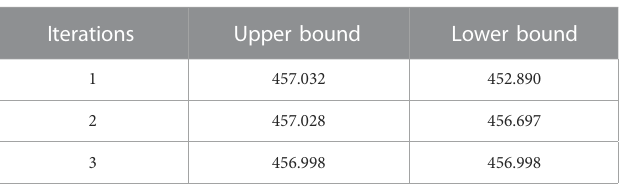
FIGURE 12 Comparison diagram of OLTC control results. TABLE 4 Results of iterative convergence.